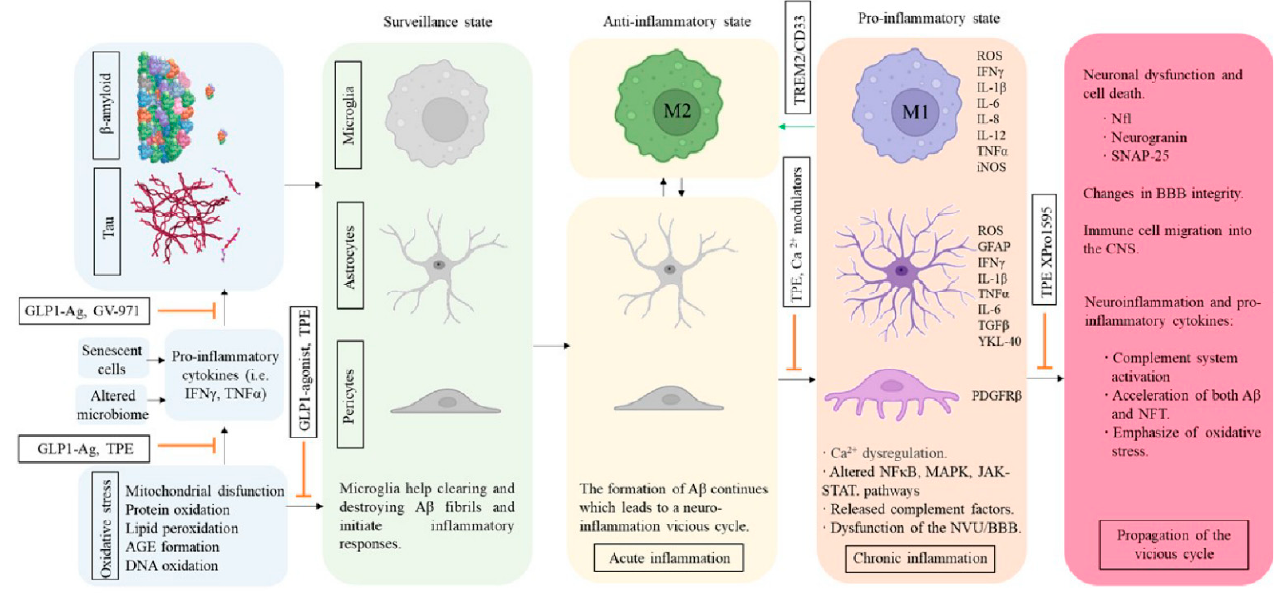
Figure 3. Anti-inflammatory strategies for the development of DMT. Inflammation plays a central role in AD and at this moment is the main therapeutical strategy in clinical development for AD. Some molecules target specific players of inflammation or microglial activation (such as TNF α , TREM2, or CD33) while others have a broader anti-inflammatory effect (GLP1 agonist, Plasma